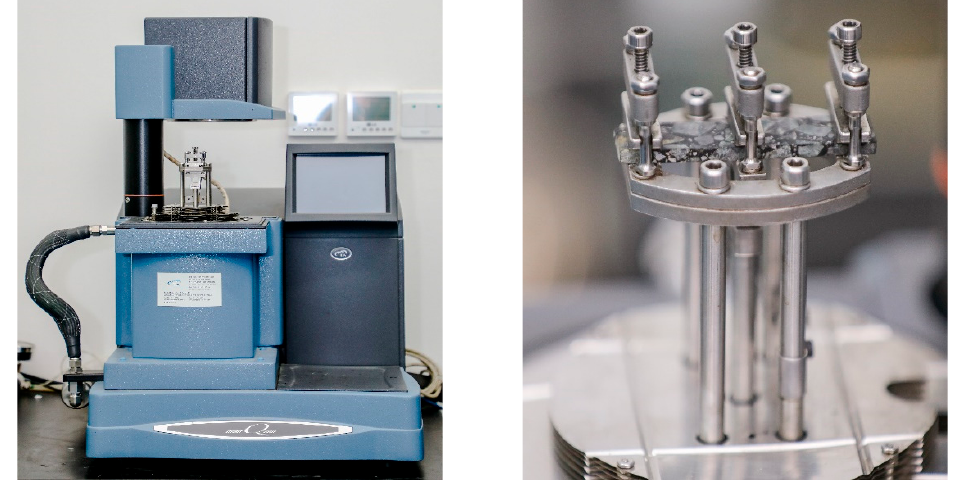
Figure 5. Test apparatus: DMAQ800.